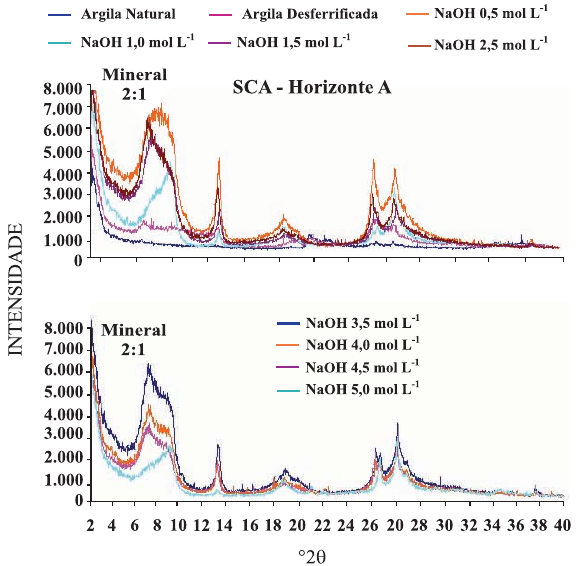
Figura 1. Difratogramas de raios X de amostras orientadas de argila natural e desferrificada, antes e após os tratamentos com diferentes concentrações de NaOH, do horizonte A do perfil do Setor de Ciências Agrárias (SCA) da UFPR. A distância basal d(001) do mineral 2:1 variou de 1,32 nm (NaOH 2,5 mol L -1 ) a 1,0 nm (NaOH 5 mol L -1